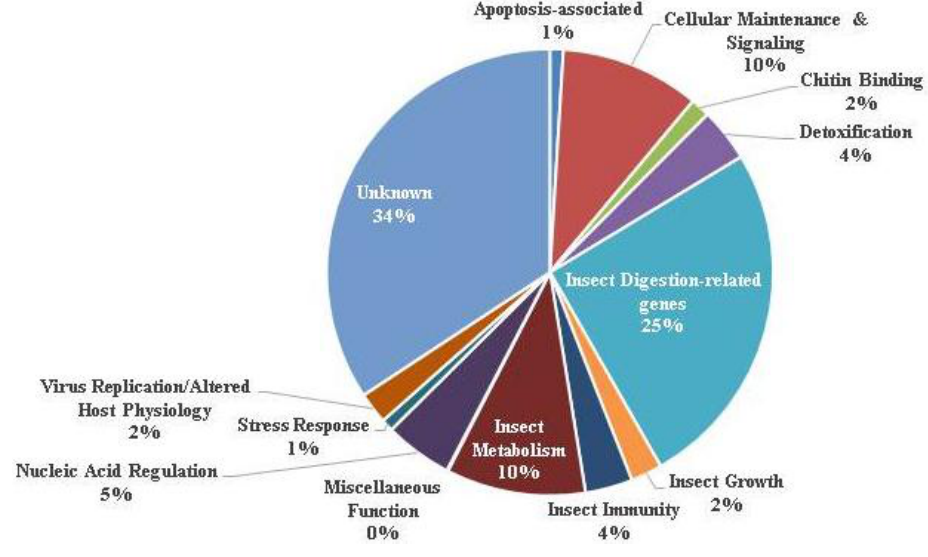
Figure 2. Number of genes stimulated or repressed due to viral infection associated with specific gene groups. Groups shown were most affected 24 h post infection in the gut